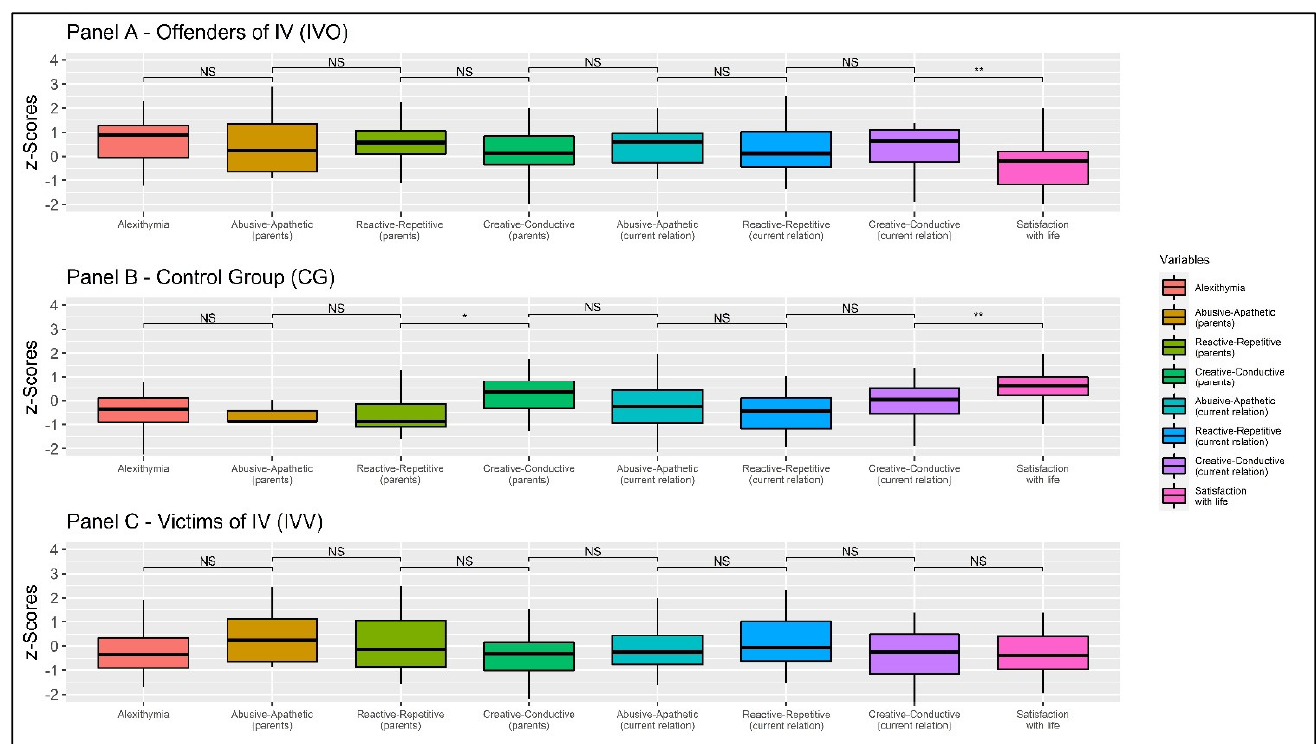
Figure 3. Plot of the within-group differences (flatness). Note: NS: p > 0.50; * p < 0.050; ** p < 0.010;.